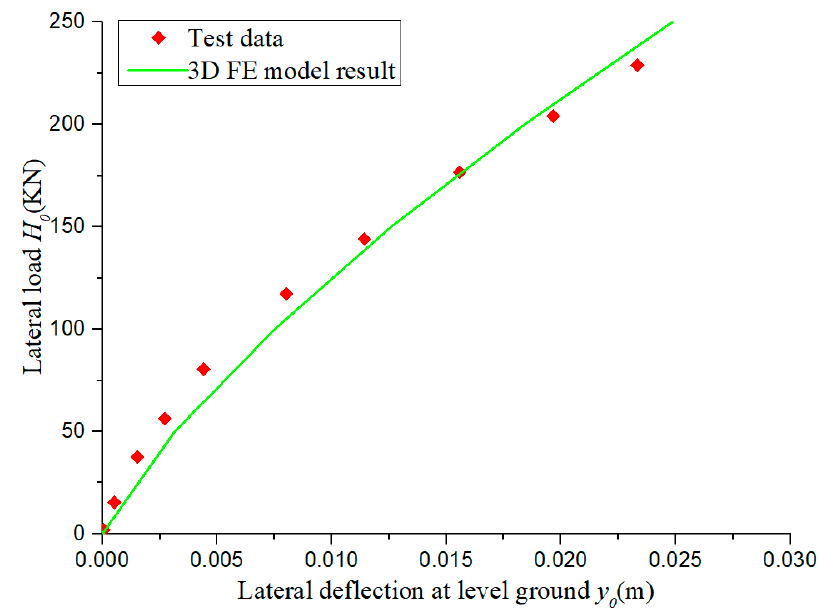
Figure 9. Validation of 3D finite element modeling method. Table 1. Soil and pile parameters in 3D FE model.